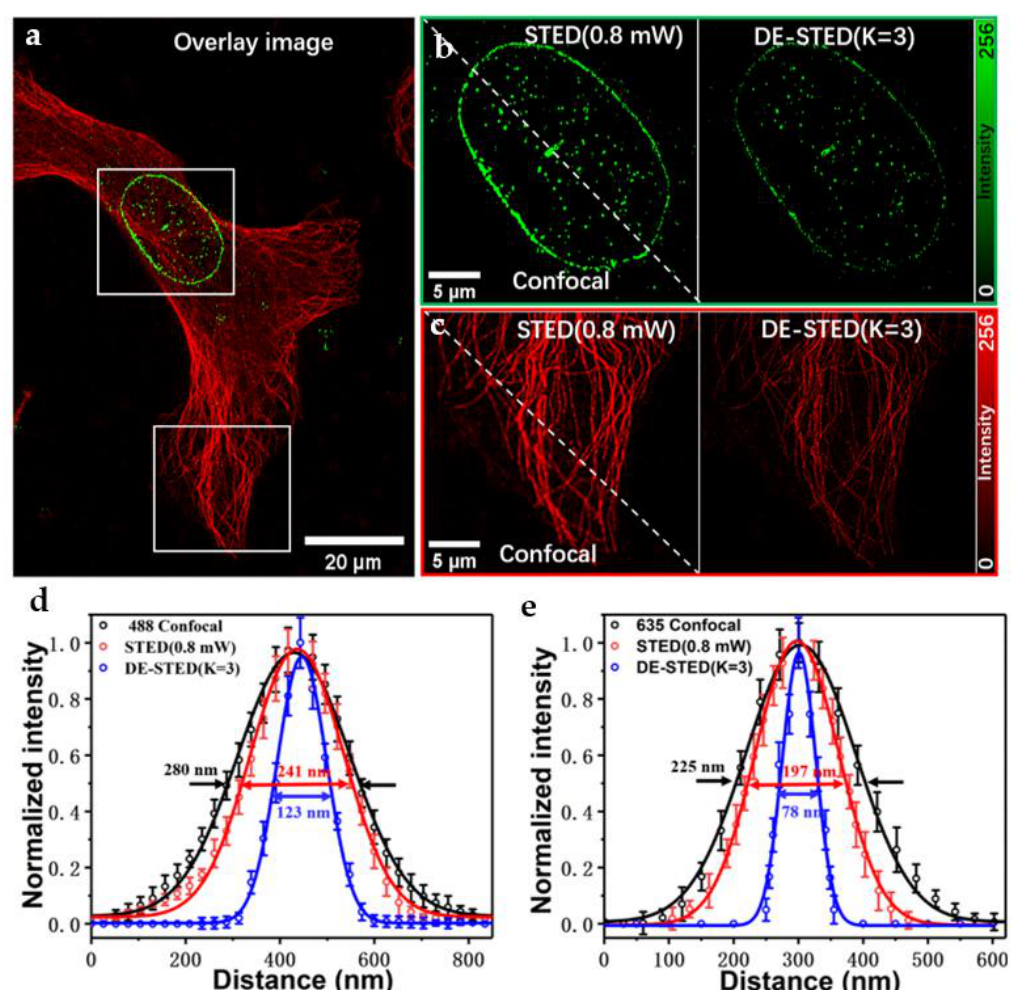
Figure 4. Two-color DE-STED imaging results from the same fixed U2OS cell. ( a ) Merged confocal images of two-color channels including nuclear membrane (green) and microtubules (red). The white frame area in the figure is the research object. ( b ) Confocal, STED (0.8 mW), and DE-STED ( k = 3) images of the nuclear membrane in the green channel. ( c ) Confocal, STED (0.8 mW), and DE-STED ( k = 3) images of the microtubule in the red channel. ( d ) The average FWHM of the nuclear membrane in the confocal, STED (0.8 mW), and DE-STED ( k = 3) images in ( b ). ( e ) The average FWHM of microtubule in the confocal, STED (0.8 mW), and DE-STED ( k = 3) images in ( c ). Scale bars : 20 and 5 μm.